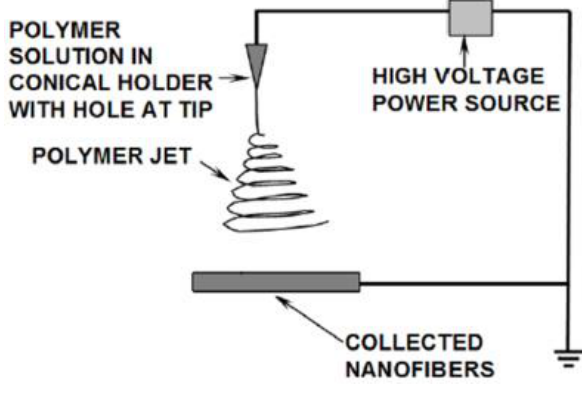
Figure 1. Electrospinning